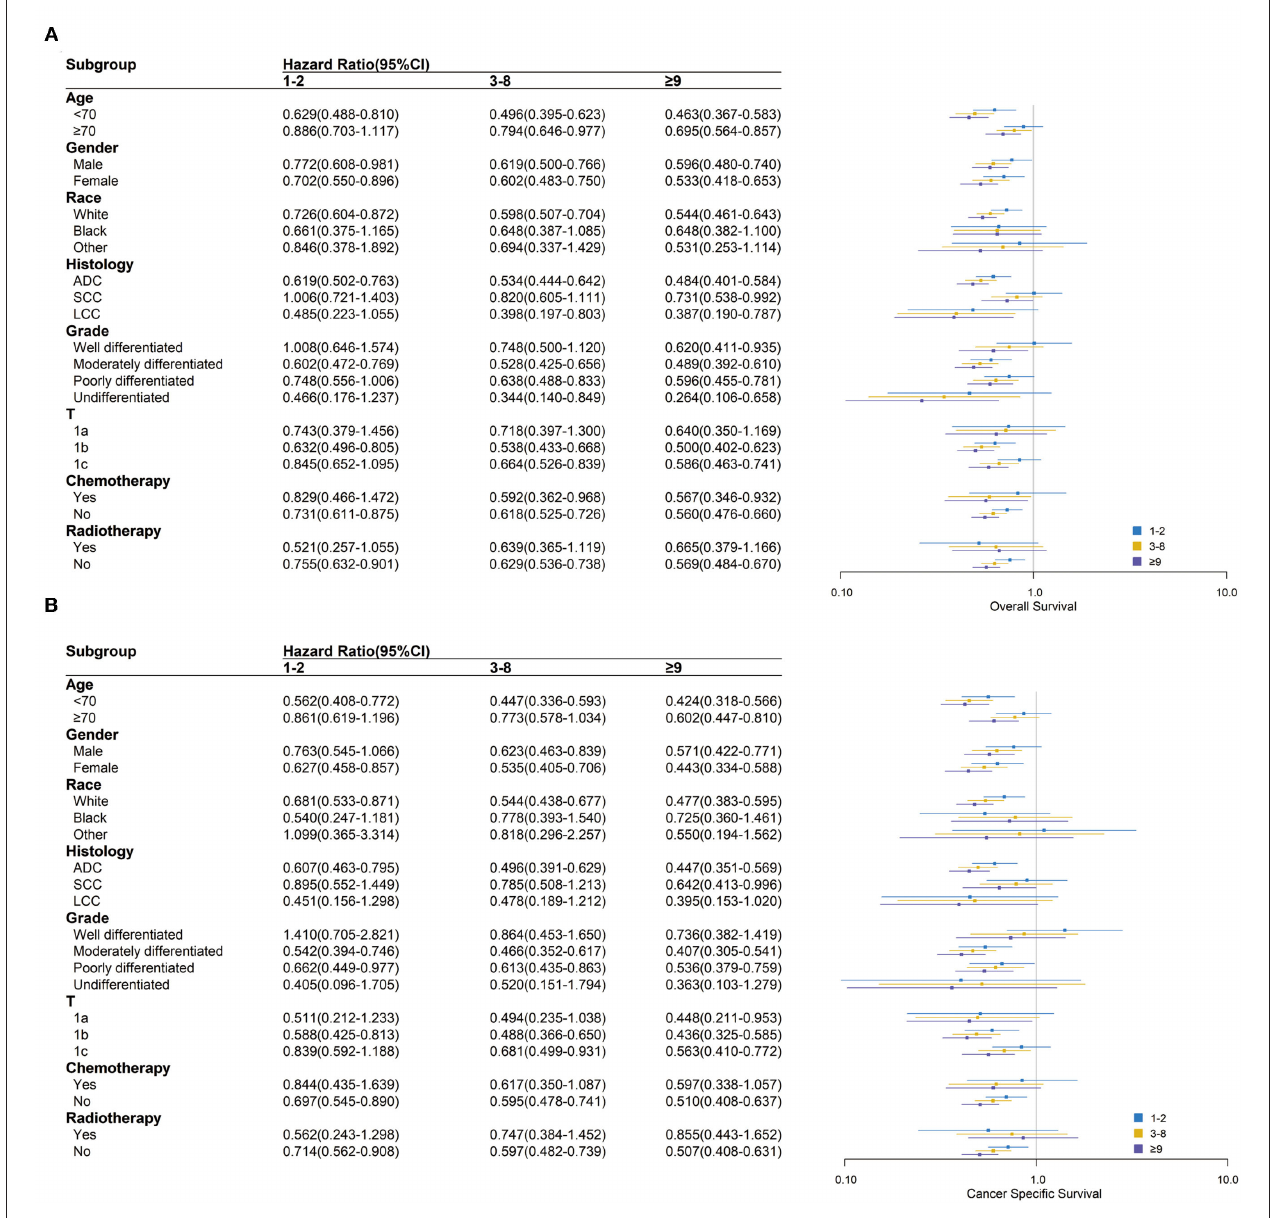
FIGURE 3 | Over survival (A) and cancer-specific survival (B) comparison among 0, 1–2, 3–8, and ≥ 9 lymph nodes examined in different clinicopathological subgroups analysis. Blue, yellow and purple boxes represent the hazard ratios (HRs) of 1–2, 3–8 and ≥ 9 lymph nodes examined respectively. The lines represent the 95% CI of